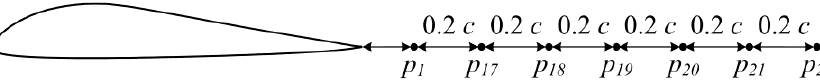
Figure 16. Diagrammatic sketch of the near-field noise observing points in the radial direction.